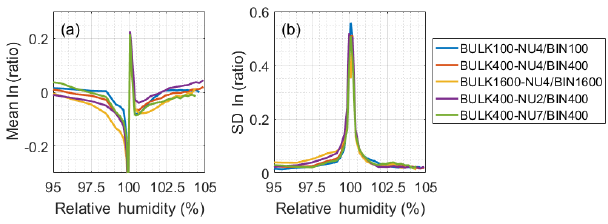
Figure 4. The (a) mean ln(ratio) and (b) standard deviation of the ln(ratios) as a function of relative humidity for all five simulation pairs.